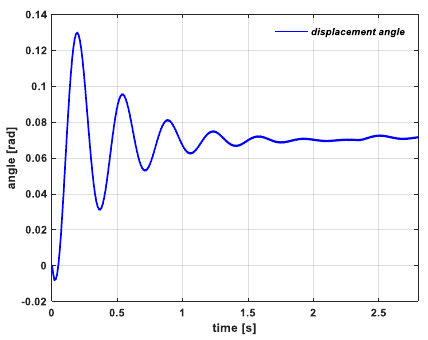
Figure 7. Time behavior of displacement angle α.